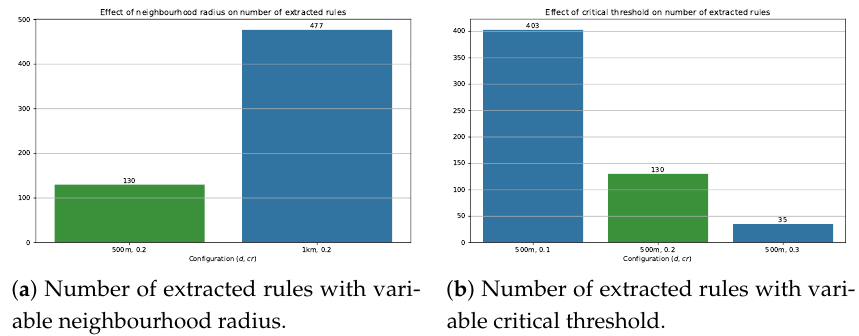
Figure 6. Number of extracted rule with variable